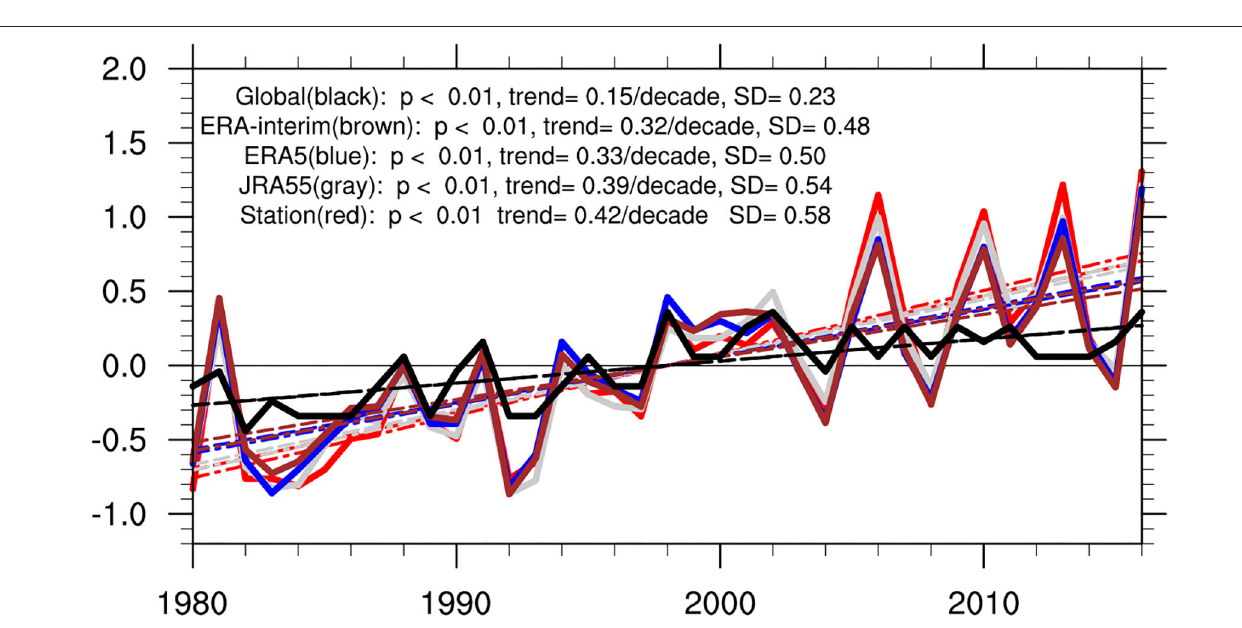
FIGURE 2 | Interannual changes in summer temperature averaged by the Tibetan Plateau and globe (black) for in situ stations (red), JRA55 (gray), ERA5 (blue), ERA–Interim (brown), and globe (black, JRA55) (units: ◦ C). Significances of the trends are assessed using the Mann–Kendall test and Theil–Sen estimator. P < 0.01 indicates a significant difference above the 99% confidence